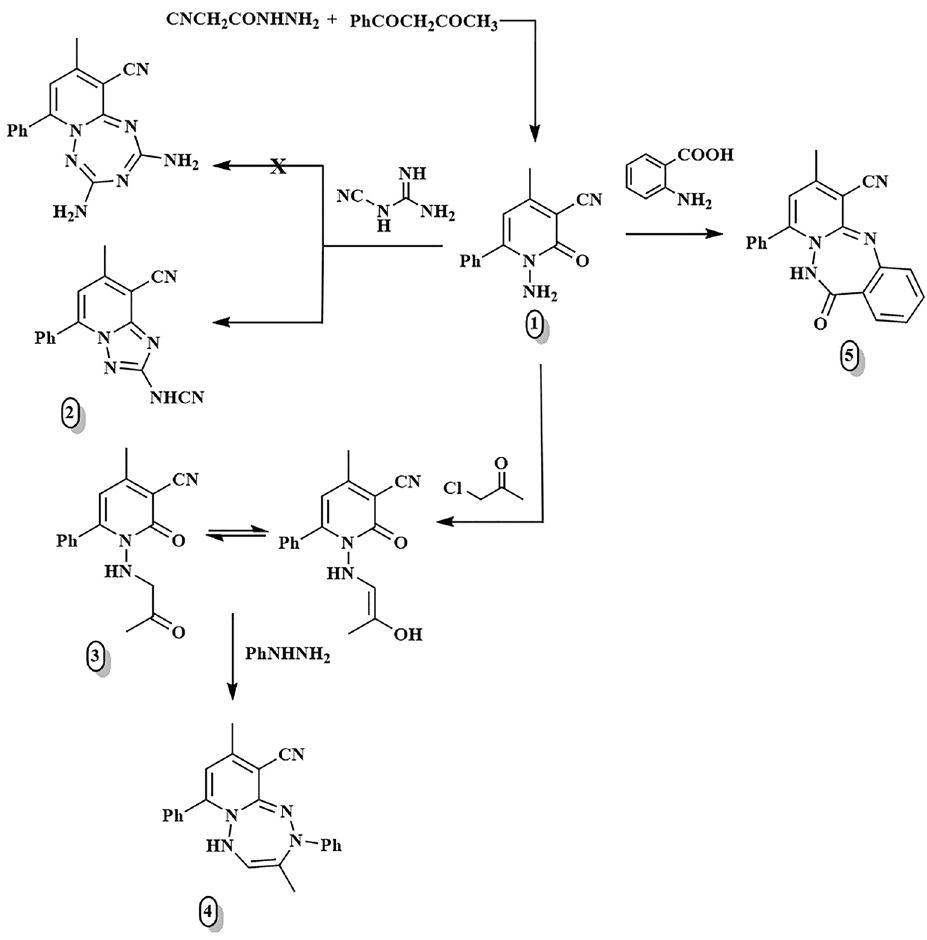
Figure 1. Synthesis of compounds 2 –